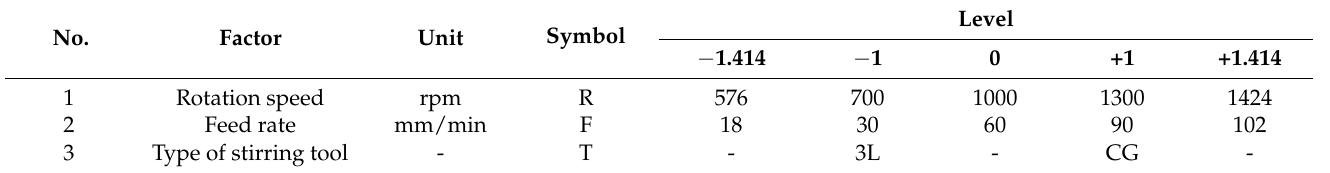
Table 2. Friction stir welding experiments designed using factors, levels, and